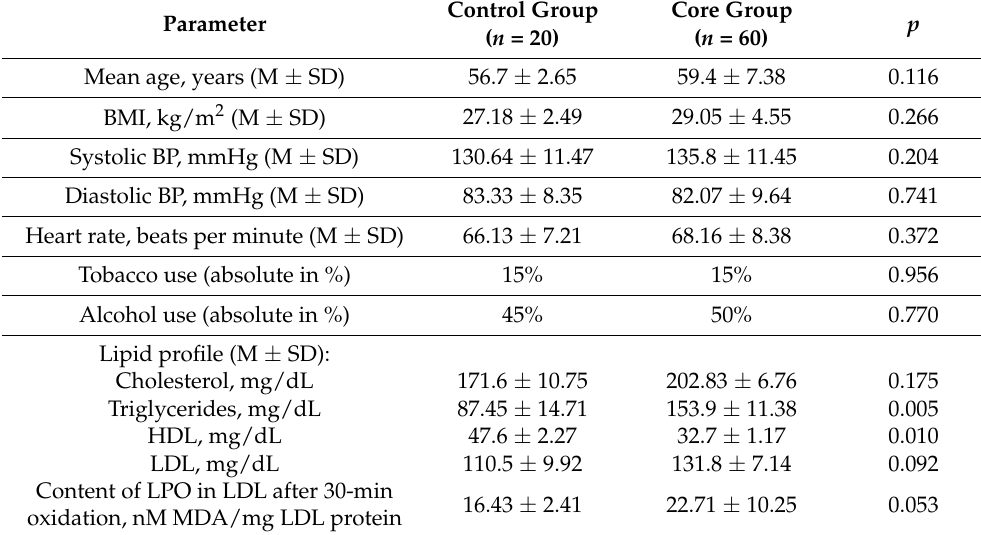
Table 1. Characteristics of patients in the core and control